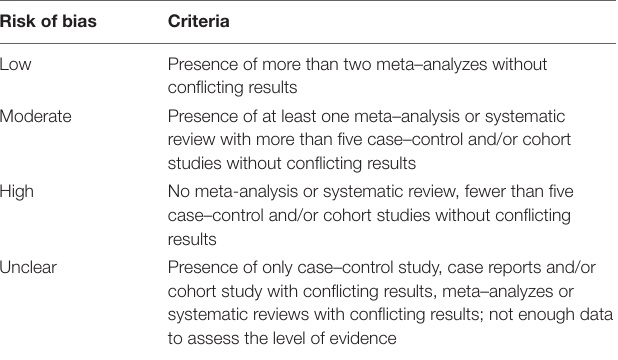
TABLE 1 | Risk of bias evaluation